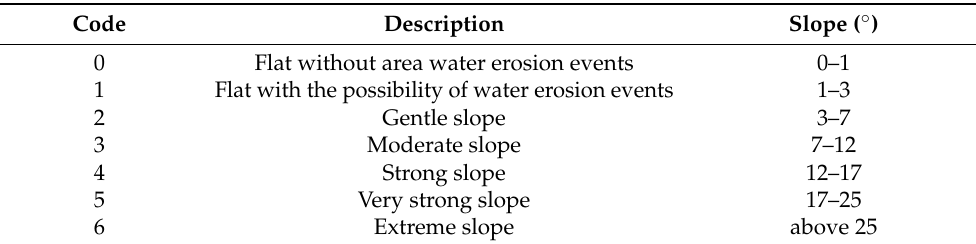
Table 2. Slope codes.